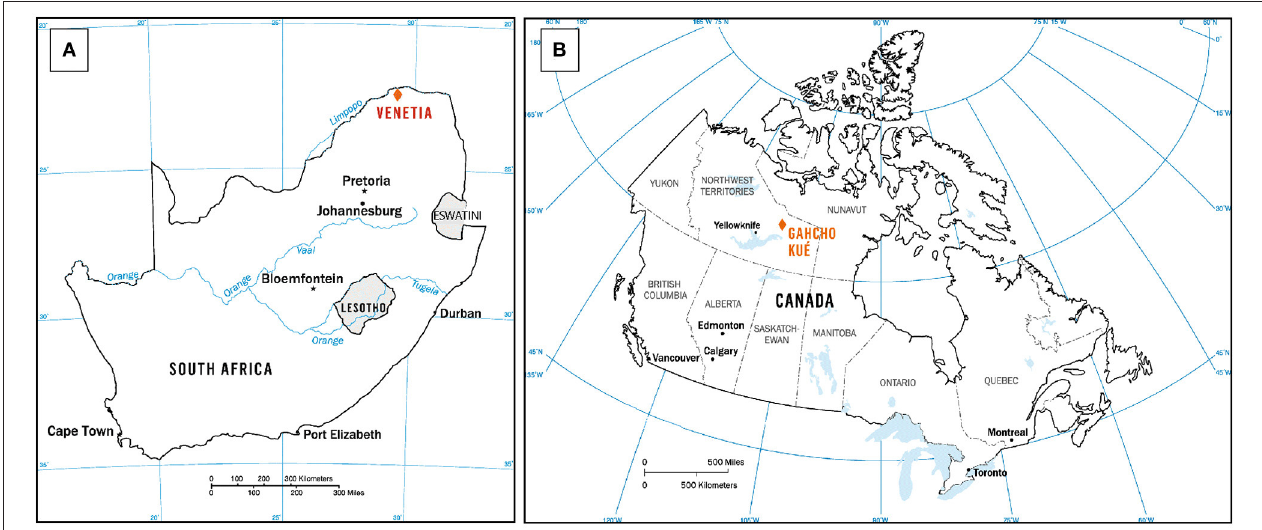
FIGURE 2 | Maps showing the location (marked by orange diamond symbols) of: (A) Venetia mine in South Africa; (B) Gahcho Kué mine in Canada. Modified after Mervine et al. (2018).